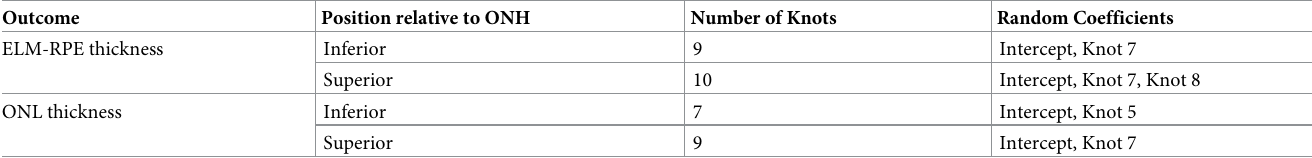
Table 1. Model details for OCT layer thickness